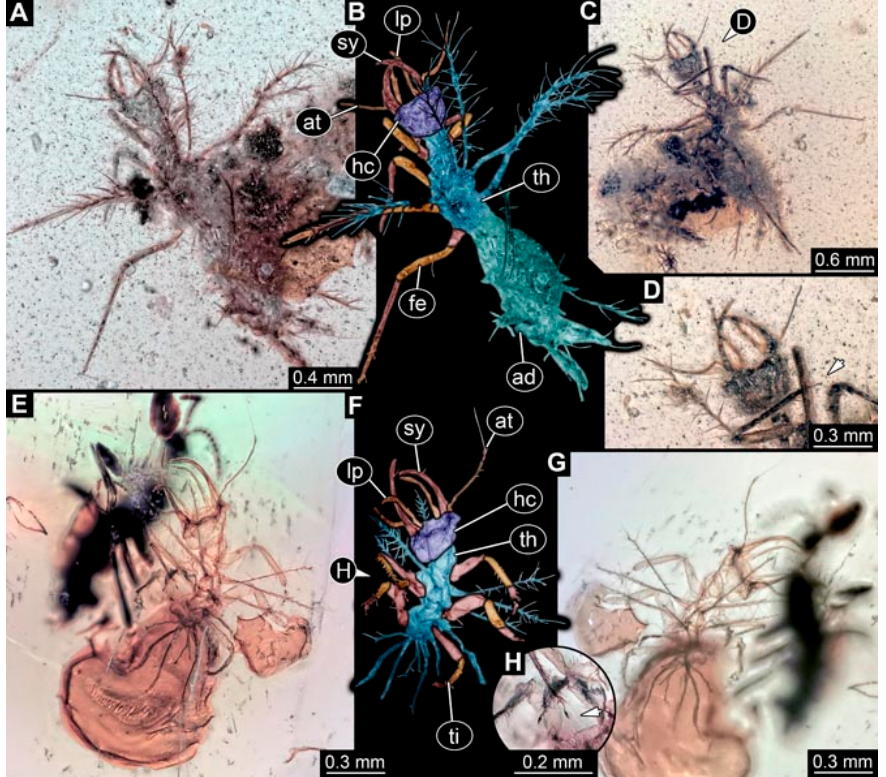
Figure 16. Two specimens in Myanmar amber. ( A – D ) Specimen 4836 (PED 0315). ( A ) Dorsal view. ( B ) Dorsal view, colour-marked. ( C ) Ventral view. ( D ) Close-up of trunk appendage with empodium (arrow). ( E – H ) Specimen 4837 (PED 0323). ( E ) Dorsal view. ( F ) Dorsal view, colour-marked. ( G ) Ventral view. ( H ) Close-up of trunk appendages with empodium (arrow). Abbreviations: ad = abdomen; at = antenna; fe = femur; hc = head capsule; lp = labial palp; sy = stylet; th = thorax; ti = tibia.